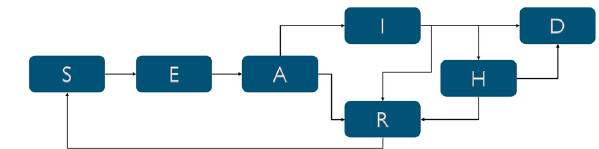
Fig. 5 Disease transmission model states and